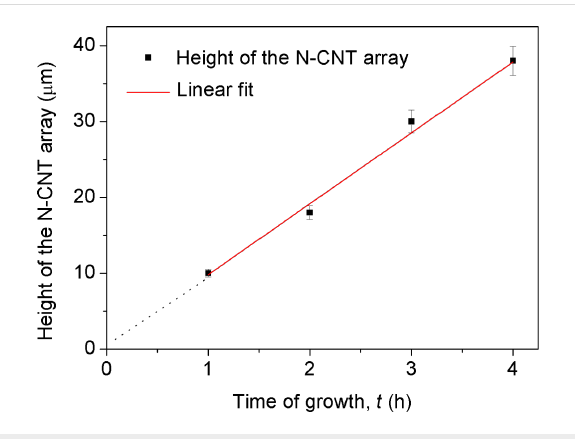
Figure 7: The height of the N-CNTs array vs time of growth.